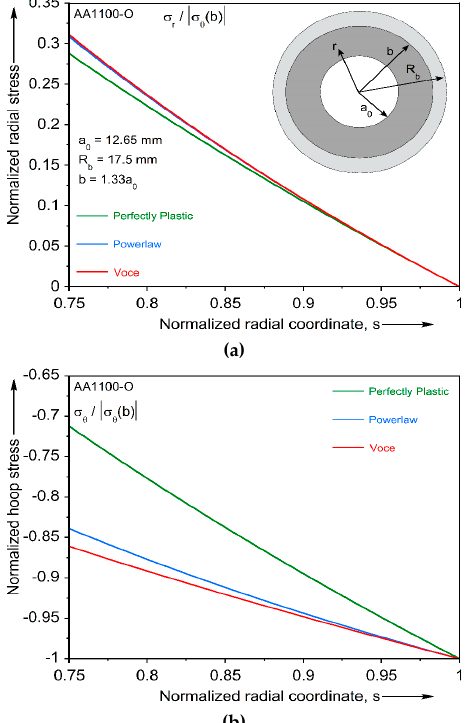
Figure 8. Normalized stress distribution in the flange for perfectly plastic ( σ e = 30 MPa), powerlaw ( σ e = 160 ( ε e ) 0.24 MPa), and Voce hardening (Equation (16)) models when the hoop strain at the outer periphery is 0.04. ( a ) Radial stress; ( b ) hoop stress.